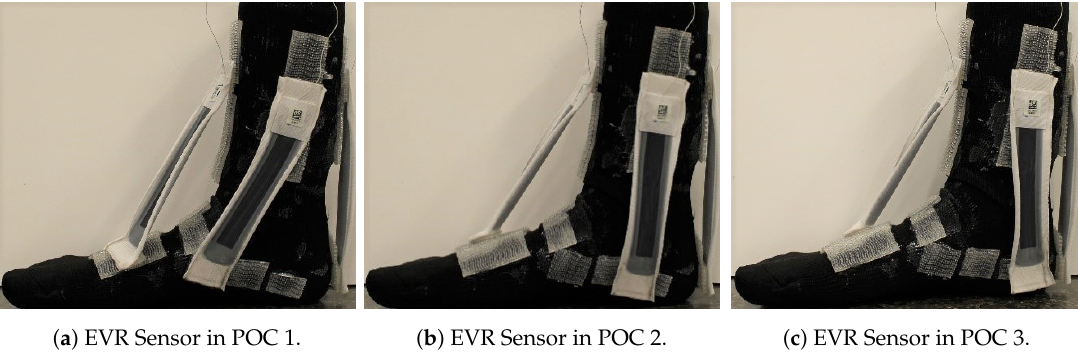
Figure 5. EVR sensor POC positions: ( a ) POC 1; ( b ) POC 2; and ( c ) POC